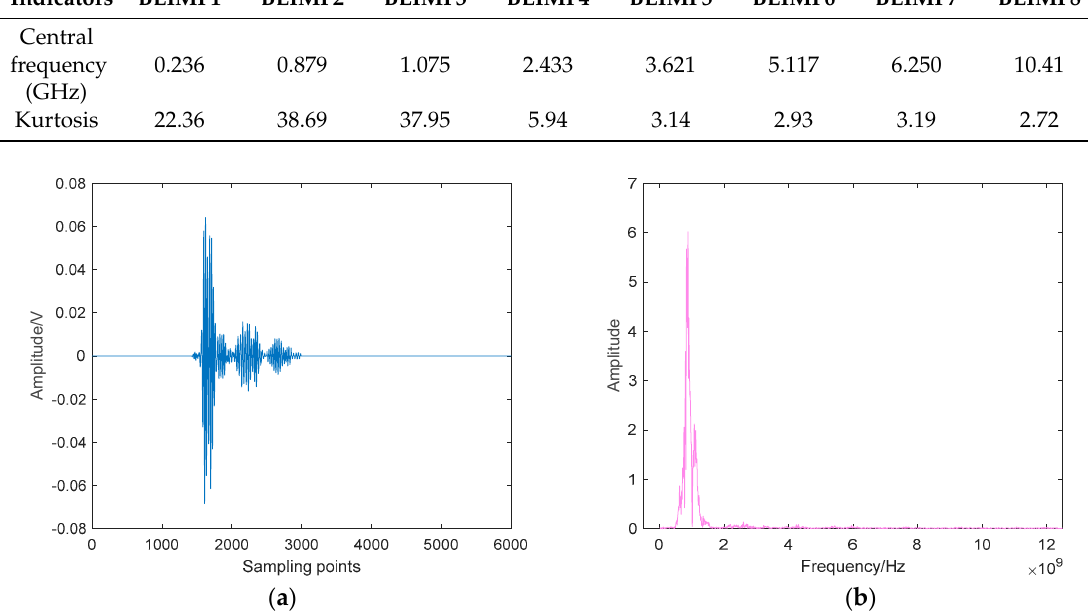
Figure 18. BLIMFs decomposed by VMD using the optimal K : ( a ) Time-domain waveforms; ( b ) Spectra. Table 5. Central frequencies and kurtosis values of the BLIMFs of the above UHF PD signal.